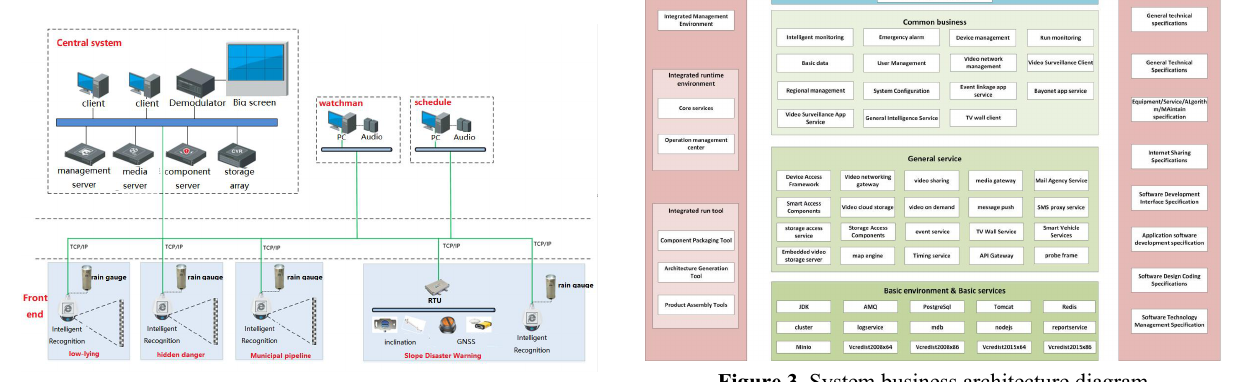
Figure 1 . Overall topology of the system.